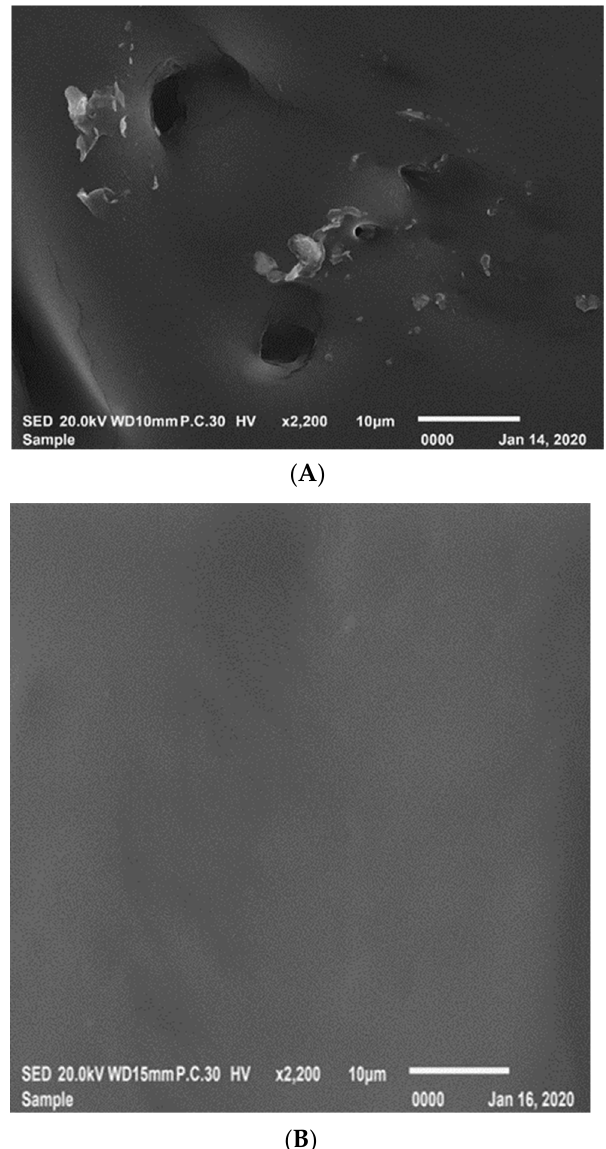
Figure 9. The SEM images of aged bitumen and rejuvenated bitumen. ( A ) Aged bitumen; ( B ) rejuvenated bitumen by the RNCCD process. Table 4. The EDX results of aged bitumen and rejuvenated bitumen.